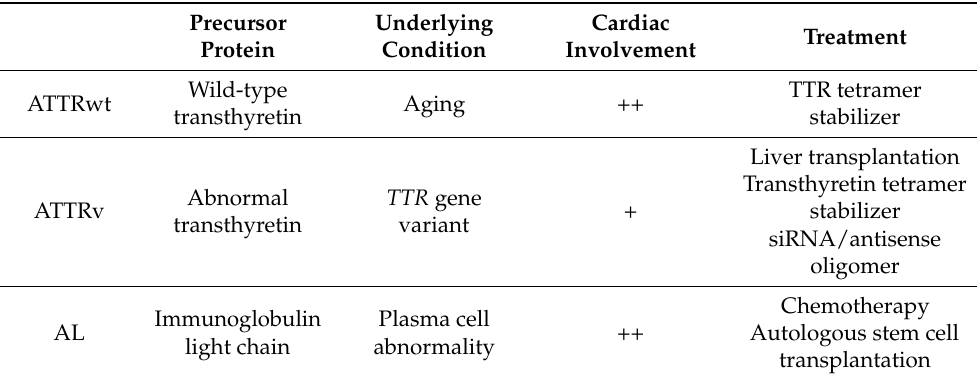
Table 1. Classification of cardiac